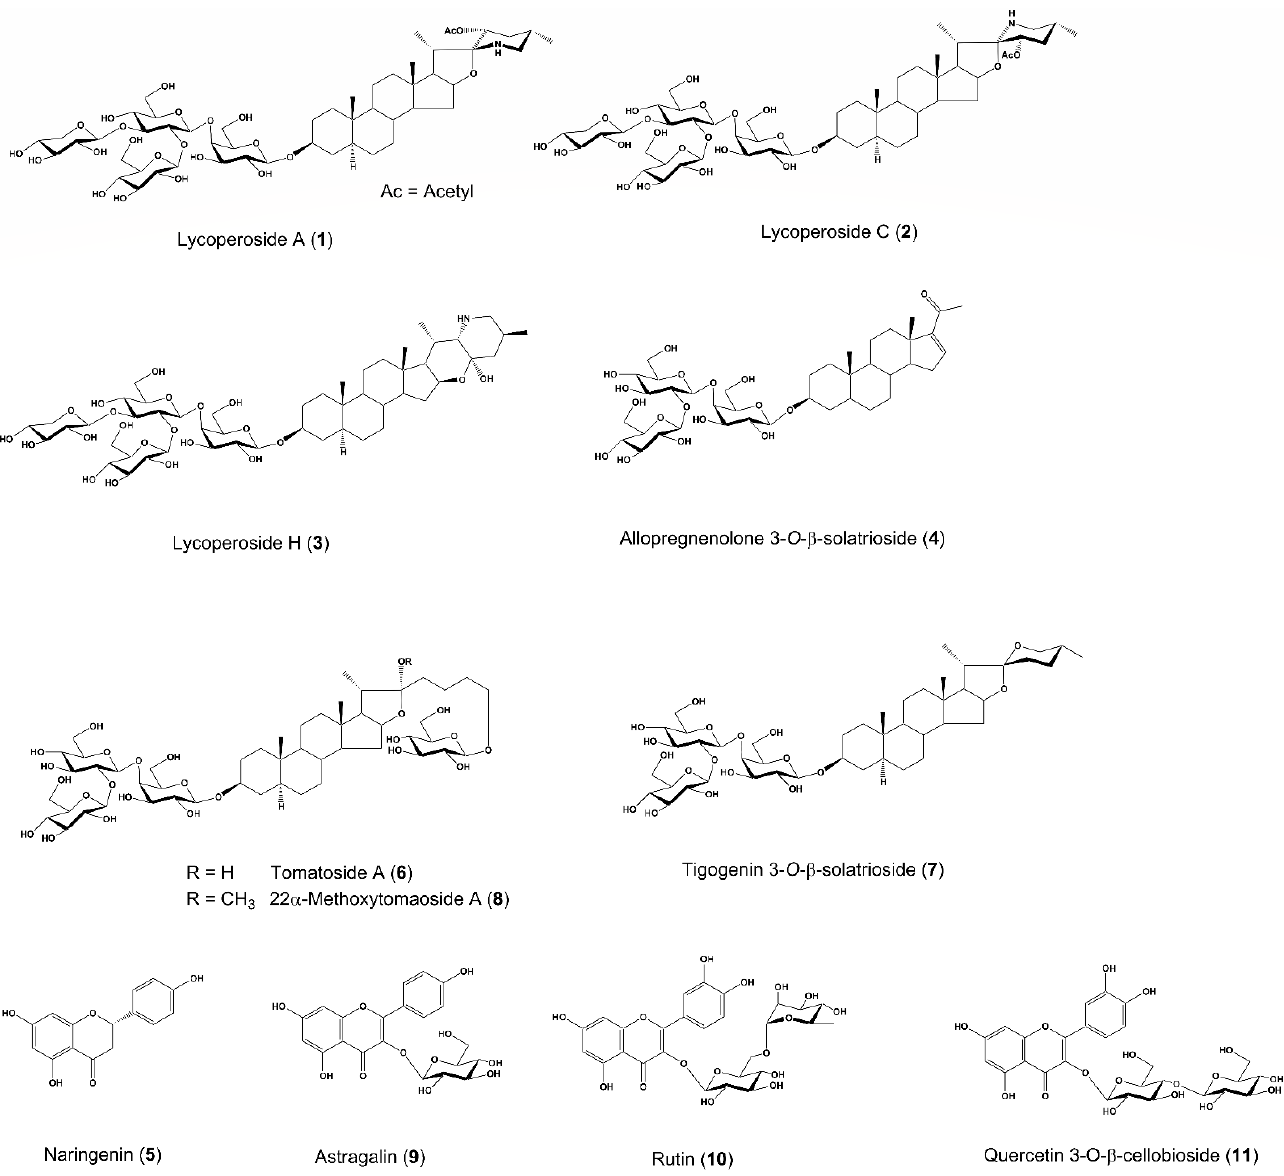
Figure 1. Chemical structures of the isolated compounds ( 1 – 11 ) from tomato seeds.